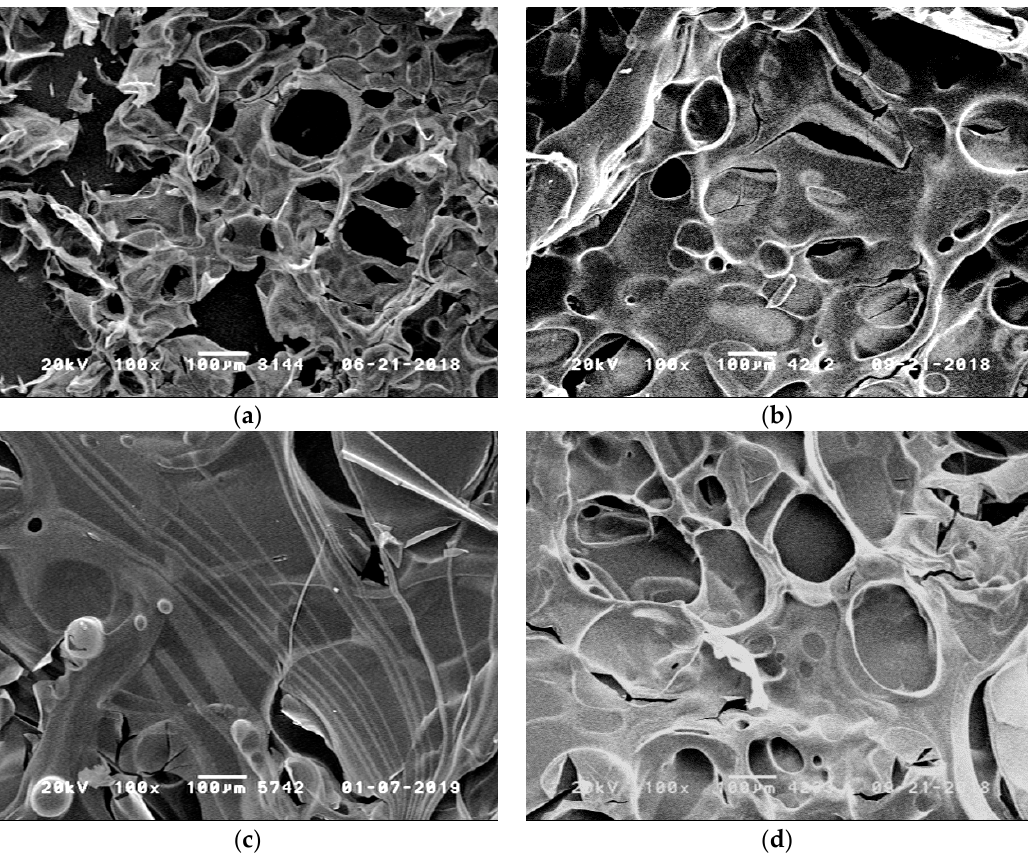
Figure 8. Scanning electron microscope (SEM) images of the residues obtained after cone calorimetry at 35 kW·m − 2 for 10 min: ( a ) RTM6; ( b ) RTM6 + 10% TAHHT-DOPO; ( c ) RTM6 + 10% TAHHT-DDPO; ( d ) RTM6 + 10% TAHHT-DOPO-DDPO.